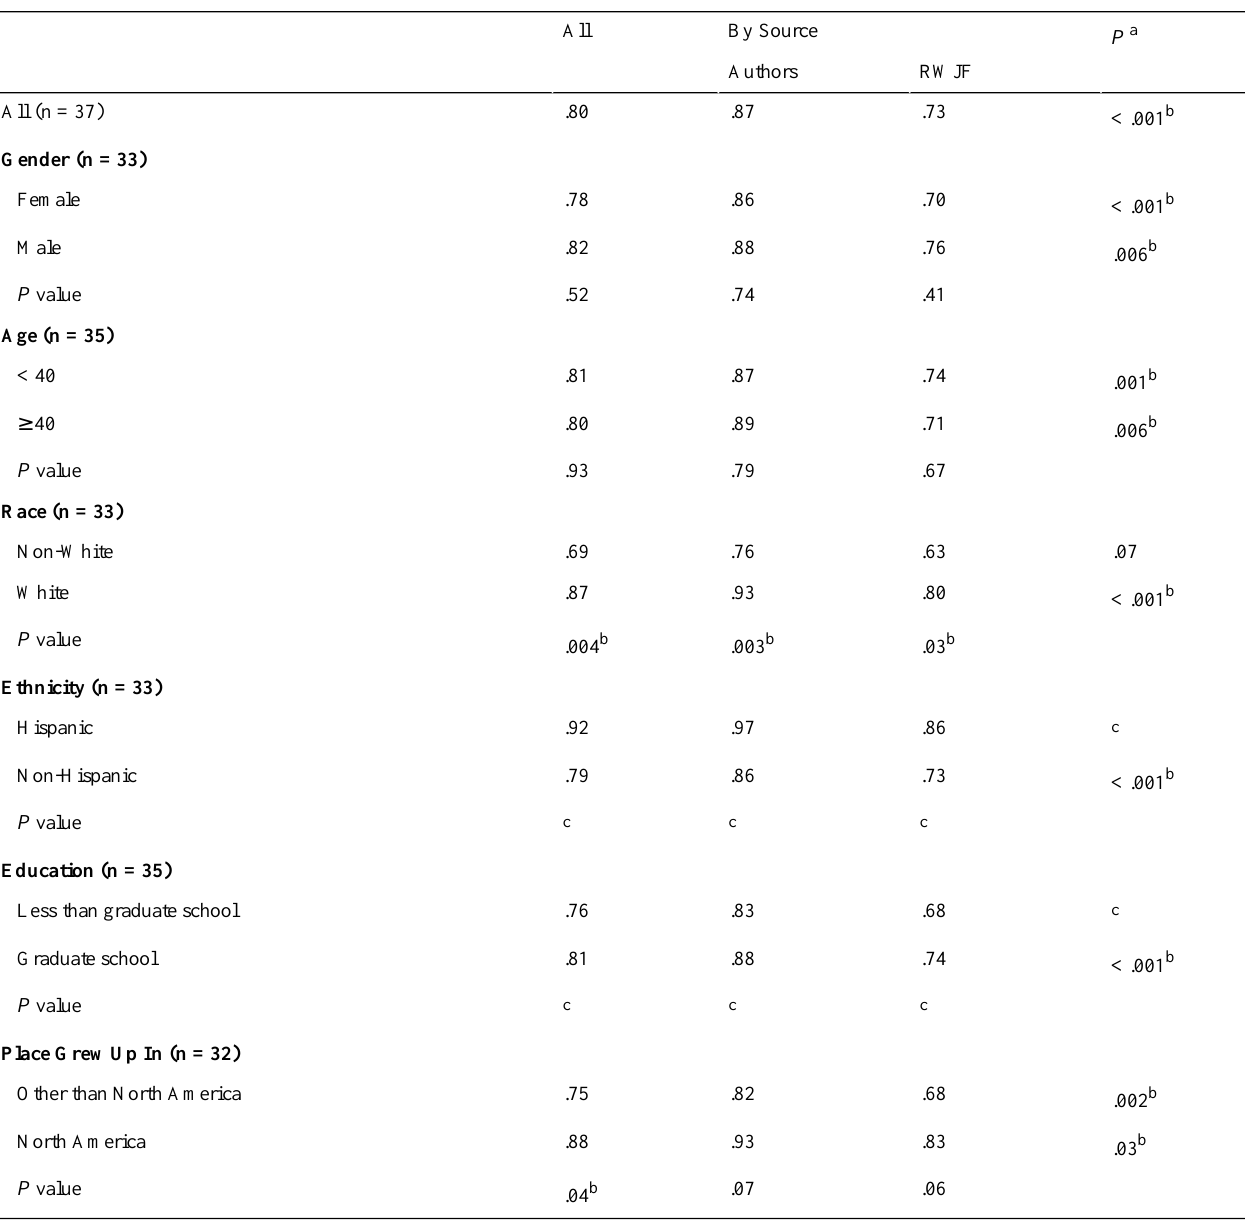
Table 3. Weighted recognition scores by demographics and sources